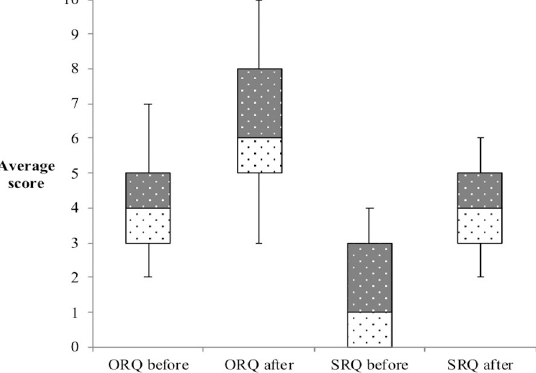
Fig 1. Students formative test scores before and after the course. Box plot showing students’ (n = 25) test scores with first (white dotted) and third (grey dotted) quartile before and after the course for the ORQ and SRQ, the black line indicates median. Whiskers indicate min and max scores. Maximum score for the MCQ was ten (10) and for the SEQ six (6).